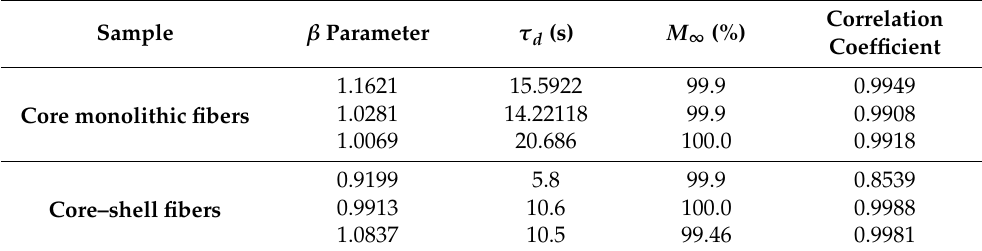
Table 3. Dissolution kinetic parameters of levocetirizine-containing monolithic fibers prepared by electrospinning and the coaxially electrospun core – shell fibers.